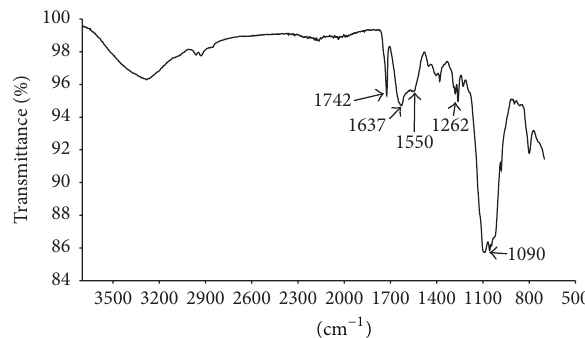
Figure 4: FTIR spectrum of the isolated EPS. It shows bands between 1000 and 1200 cm −1 ; carboxyl group at 1637 and amide II at 1550 cm −1 ; and bands at 1742 and 1262 cm −1